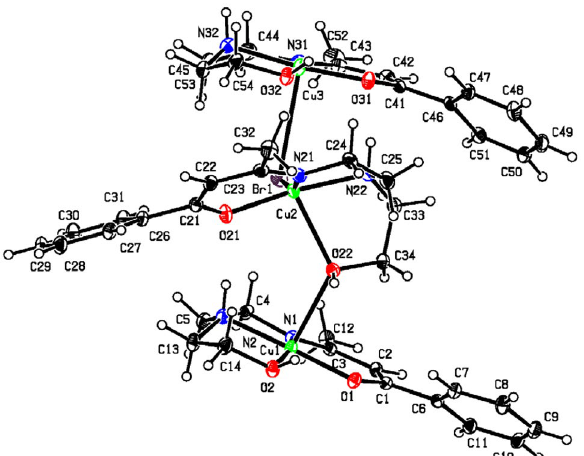
Fig. 4. The molecular structure of [Cu 3 L 3 Br] 2+ cations 3 with labe- ling of selected atoms. Fig. 5. Hirshfeld surface mapped with d